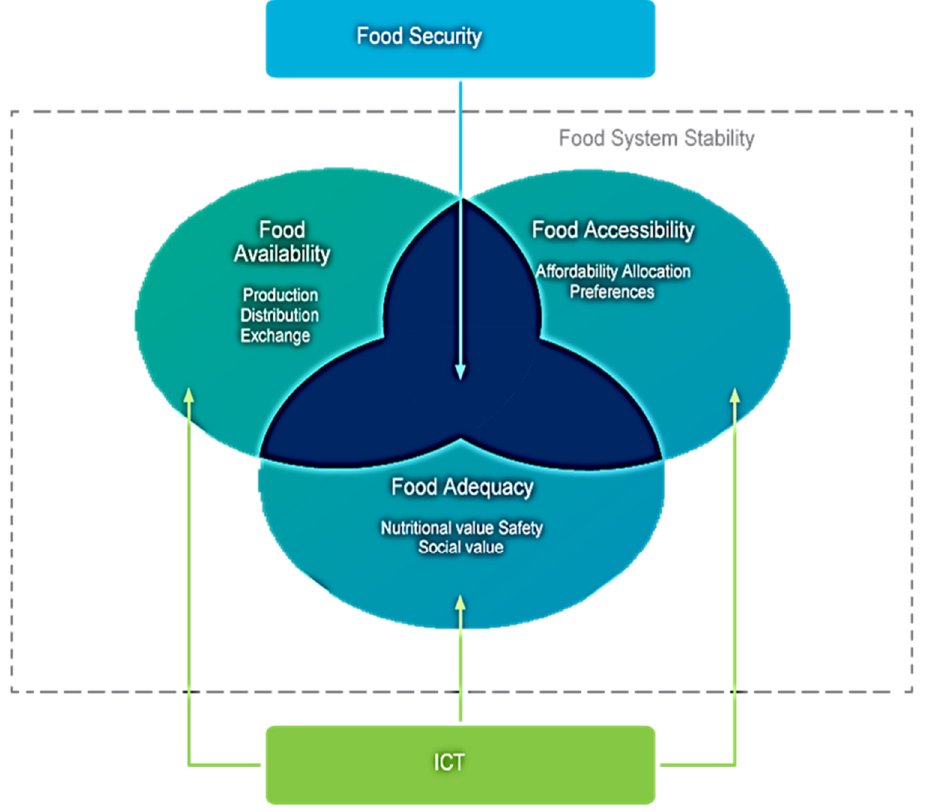
Figure 2. Sustainable food system and information and communications technology (ICT) (Adapted from Berti and Mulligan, 2015) .